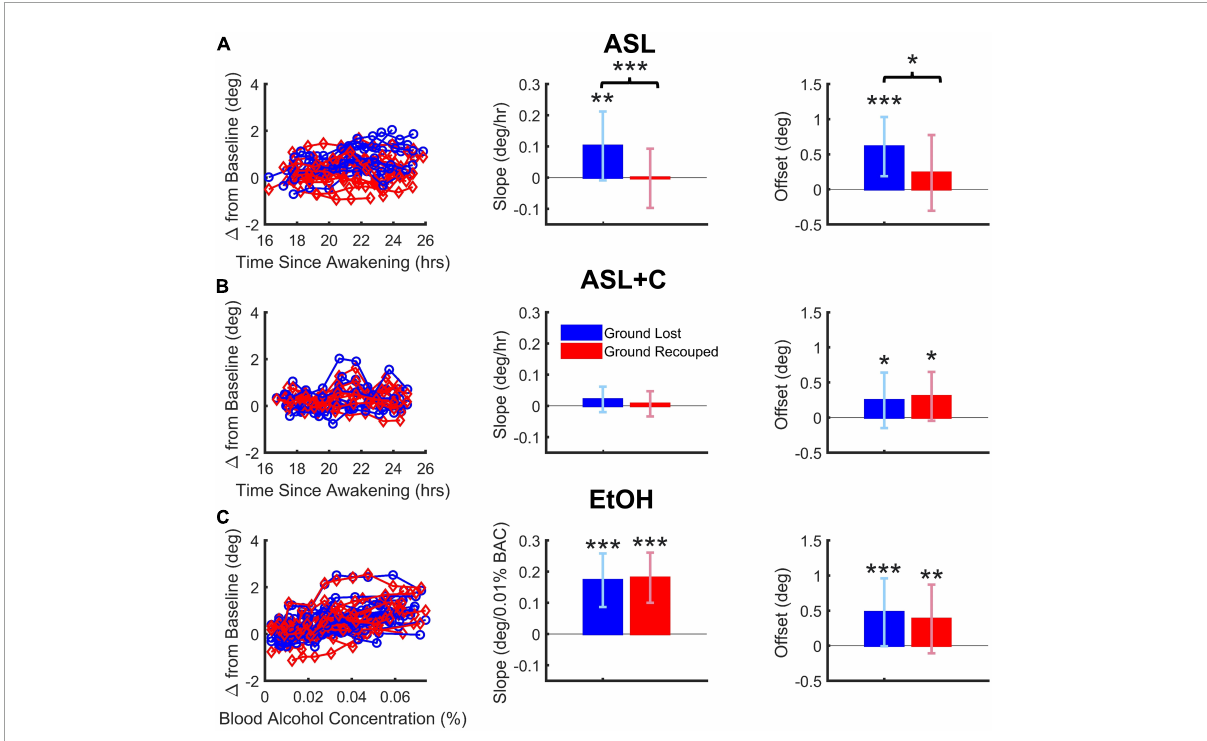
FIGURE4 Dose-dependent and overall effects on saccade-pursuit coordination. Vertical and error bars represent the across-subject mean and standard deviation (SD). (A) Under ASL, there was a significant difference between ground lost and recouped, reflected in both the dose-response sensitivity to time awake (middle column) as well as the overall effect across the range of time-awake doses tested (righthand column), indicating at best only partial saccadic compensation. (B) Under ASL+C, both the ground lost and gained became insensitive to increased wakefulness (middle) but there is a hint of a small non-dose-dependent overall saccadic overcompensation (right). (C) Under EtOH, there was a large dose-dependent increase in ground lost with increasing BAC dose, however, the ground recouped showed a dose-dependent increase sufficient to fully counteract that loss (middle) with no overall difference as well (right). * p < 0.05, ** p < 0.01, and *** p <